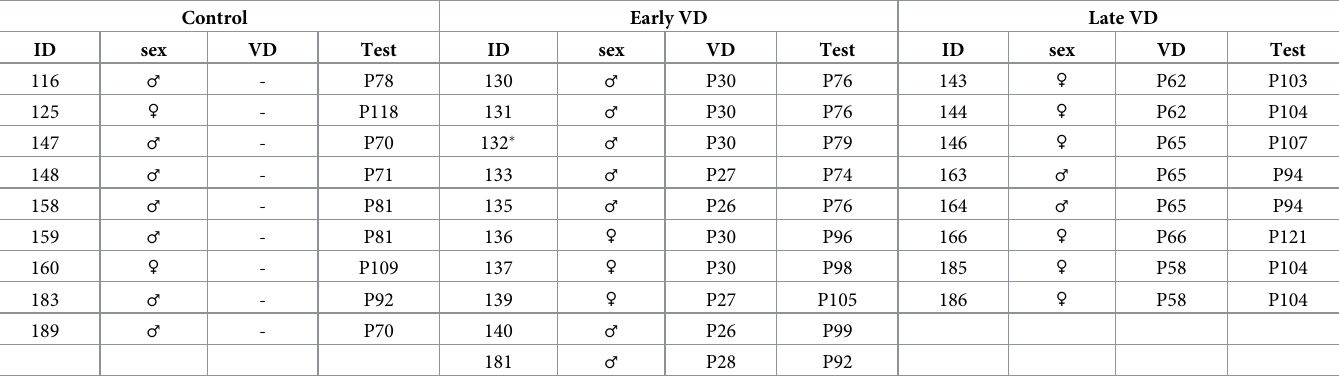
Fig 6. The shift of agility during test 3 and 4. A-C , The changes of agility during test 3, with each color indicating the individual rat in the control (A, n = 9), early VD (B, n = 10), late VD (C, n = 8) groups. D-F , Similar to A-C, but during test 4, the control (D, n = 9), early VD (E, n = 9), late VD (F, n = 8). One of 10 early VD rats was not included because its head plate was dislocated during test 4. https://doi.org/10.1371/journal.pone.0208089.g006 experiments, we used a light pulse with small t (0.1–1 ms) as a conditioning cue to measure p the reaction time precisely. In the ChR2 expressing neuron, the light-evoked depolarization depends on some parameters such as the pulse duration, the light intensity and the membrane time constant. In this case, although t was small, its standard I was large (2.9 mW/mm 2 ). In p p addition, we irradiated a wide area in the whisker-pad for the LED stimulus cue to activate many TG neurons at once. Further, the TG neuron’s membrane time constant is fast: a 1 ms mechanical stimulation can evoke neural activity and reward-related behavior [18]. Therefore, the light-evoked somatosensory perception can be formed even for a short time pulse. Less number of activated afferent inputs is also expected with the reduction of I or t . p p Table 1. W-TChR2V4 rats used for the data